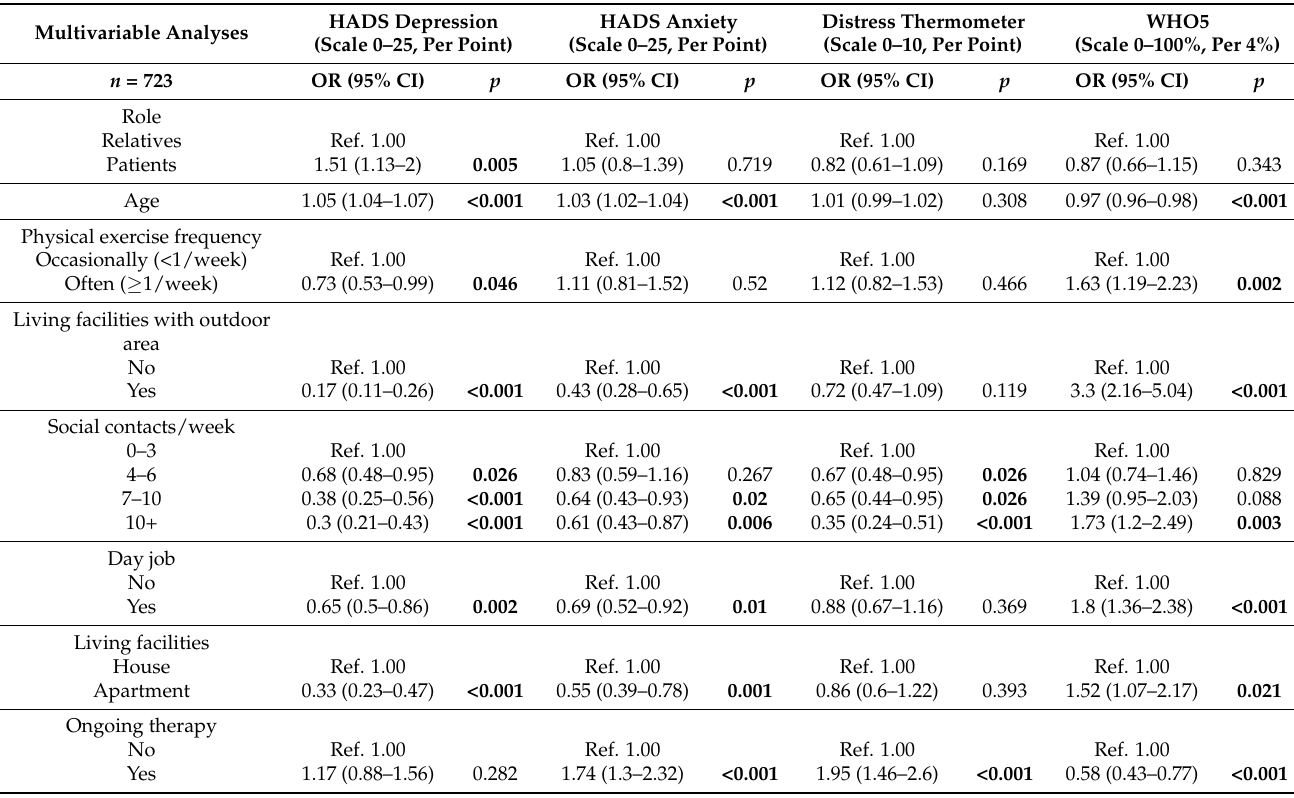
Table 3. Multivariable analyses correlating depressive symptoms and anxiety as measured by the Hospital Anxiety and Depression Scale (HADS), distress as measured by the distress thermometer, and well-being as quantified by the WHO5 scale with participant characteristics. Multivariable ordinal logistic regressions were performed to assess associations between parameters and outcomes. The same model was chosen for all four outcomes including all parameters that had shown associations with at least two outcomes in the univariable setting. A total of 723 questionnaires were included. Odds ratios, 95% confidence intervals, and p values are given for each